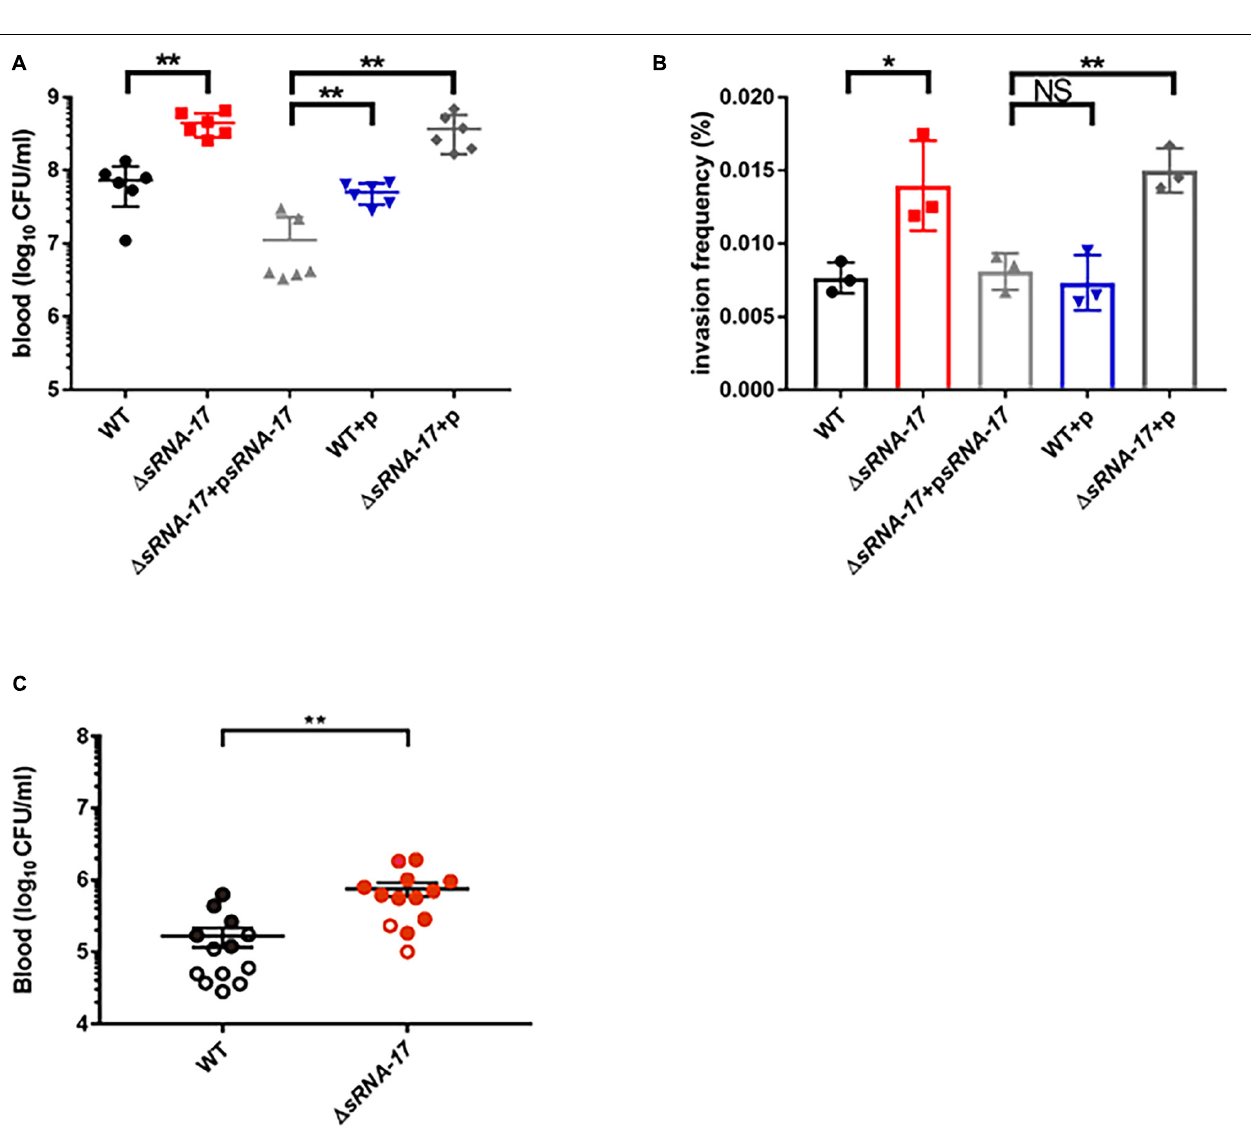
FIGURE 6 | Loss of sRNA-17 enhances Escherichia coli K1 survival in blood and penetration of the human brain microvascular endothelial cells (HBMECs). (A) Bacterial counts in the blood [colony-forming units (CFU) per milliliter] were determined 4 h after intravenous injection of E. coli K1 strains via the tail vein. (B) The invasion frequency of (cid:49) sRNA-17 and overexpressed sRNA-17 strains compared with wild-type Rs218, wild-type Rs218 with vector, and (cid:49) sRNA-17 with vector strains. (C) The magnitude of bacteremia and the development of meningitis in BALB/c mice. Bacterial counts in the blood (CFU per milliliter) were determined 4 h after intravenous injection of E. coli K1 strains via the tail vein. Each circle represents bacterial counts in the blood of individual mouse. Black, the wild-type strain; red, (cid:49) sRNA-17 strain. The shaded or open circles represent the presence or absence of positive cerebrospinal fluid (CSF) cultures in each mouse. The data are means ± SD from three independent experiments. Each experiment was performed in triplicate. * P < 0.05; ** P < 0.01; NS, no significance; P > 0.05 (Student’s t